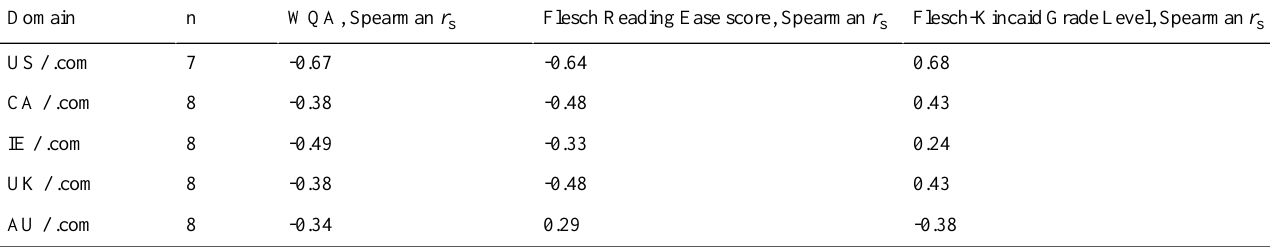
Table 2. Correlation between WQA, reading ease score, and grade level with ranking using Spearman correlation coefficient ( r s